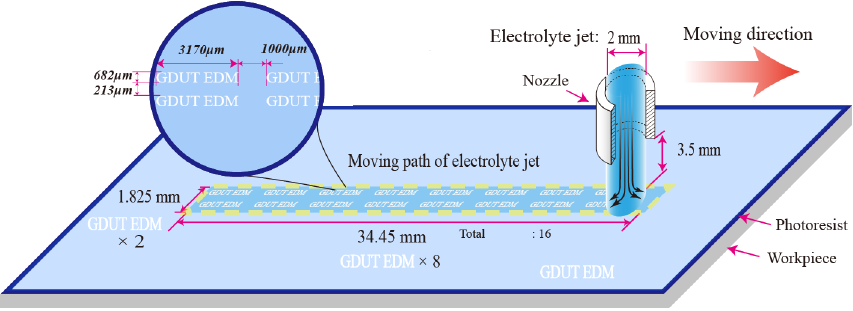
Figure 1. Schematic view of the steps in mask electrolyte jet machining process: ( a ) Photoresist coating; ( b ) Exposure; ( c ) Patterned photoresist; ( d ) Electrolyte jet mask machining; ( e ) Micro channels.